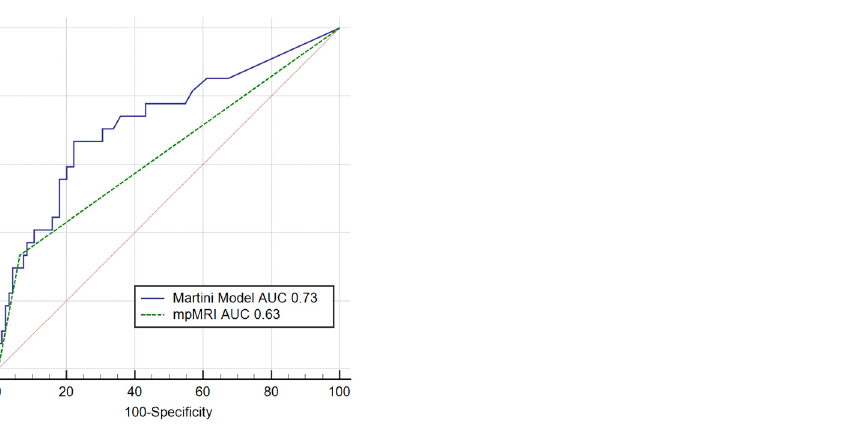
Figure 2. ROCs for the MRI and Martini models for ipsilateral EPE. ROC—receiver operating curve; AUC—area under the curve; mpMRI—multiparametric magnetic resonance imaging; EPE—extraprostatic extension; p = 0.131; Δ AUC = 0.09.